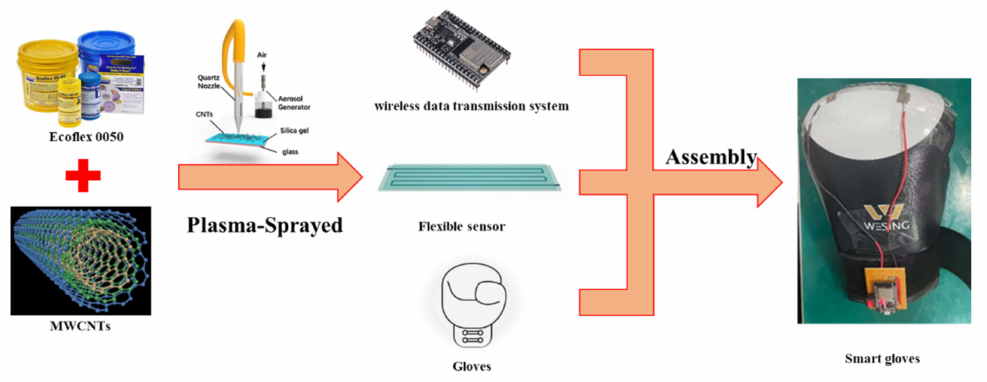
Figure 5. Flow chart for fabricating smart